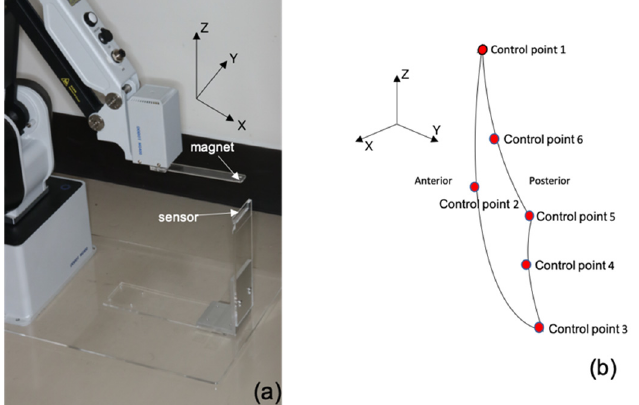
Figure 8. ( a ) Evaluation of the proposed method with the robot arm. ( b ) Posselt’s envelope composed of six control points as a model of a human jaw movement.